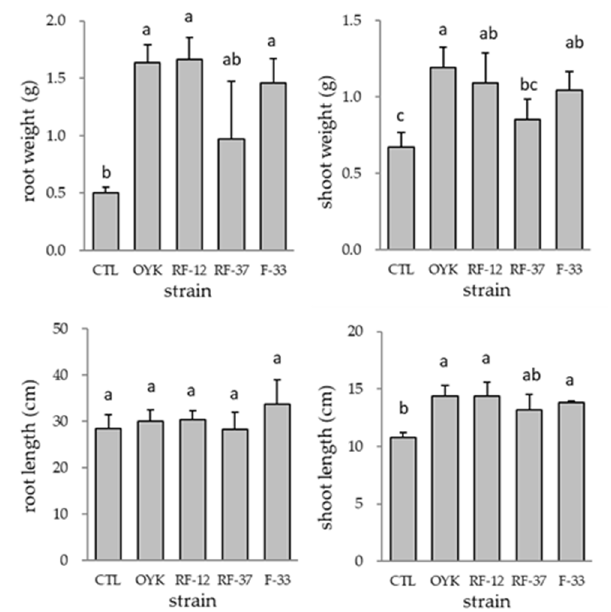
Figure 1. The effects of inoculation of Bacillus sp. strains on the growth of the tomato plant. The to- mato plant was cultivated using sterilized vermiculite, and the parameters were measured at 24 days after seed inoculation. CTL represents the control samples inoculated with autoclaved cultures. The bars represent the standard deviation (n = 6), and different letters indicate significant differences at p < 0.05 by Tukey’s test.